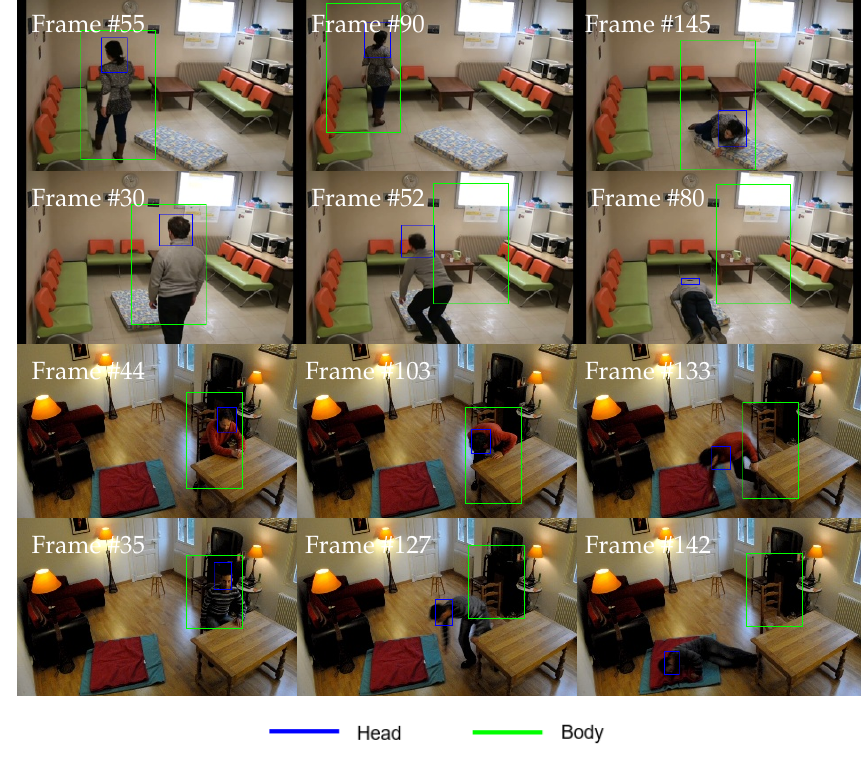
Figure 15. Comparison of B output for both head and body regions of